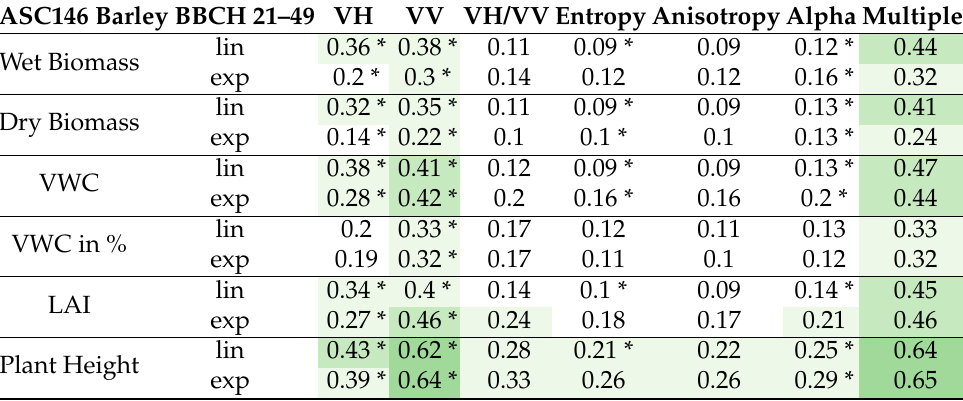
Table 6. R 2 values of the regression between crop parameters and backscatter and dual-polarimetric parameters for all barley fields in BBCH stages 21–49: the parameters of values with asterisk con- tribute to the multiple regression model. The darker the shade of green, the higher the R 2